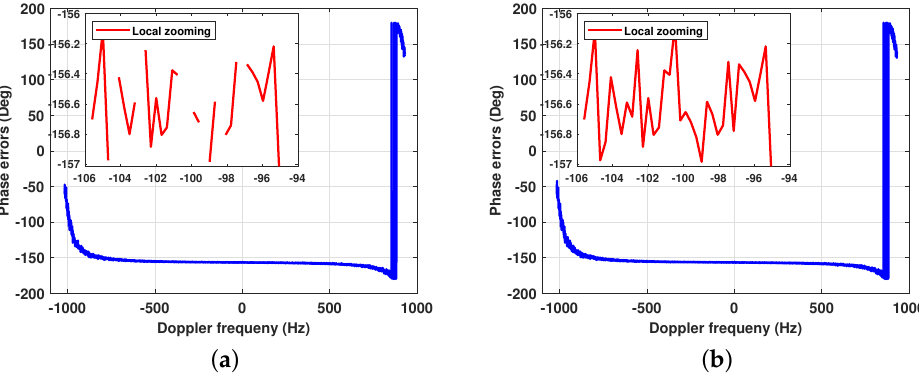
Figure 13. The results of channel phase error estimation and the local zooming. ( a ) Estimated result using the OSM. ( b ) Estimated result using the proposed